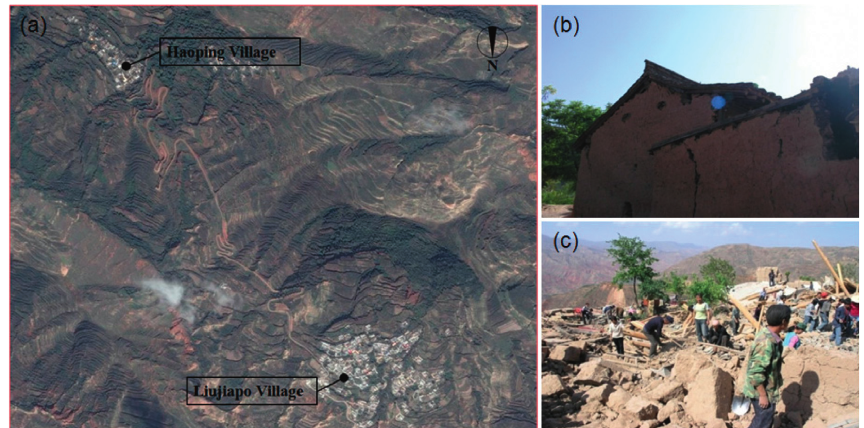
Figure 1: Differences in earthquake damage in two typical villages. (a) Topography of the two typical villages, (b) house damage in Liujiapo village, and (c) house damage in Haoping village.